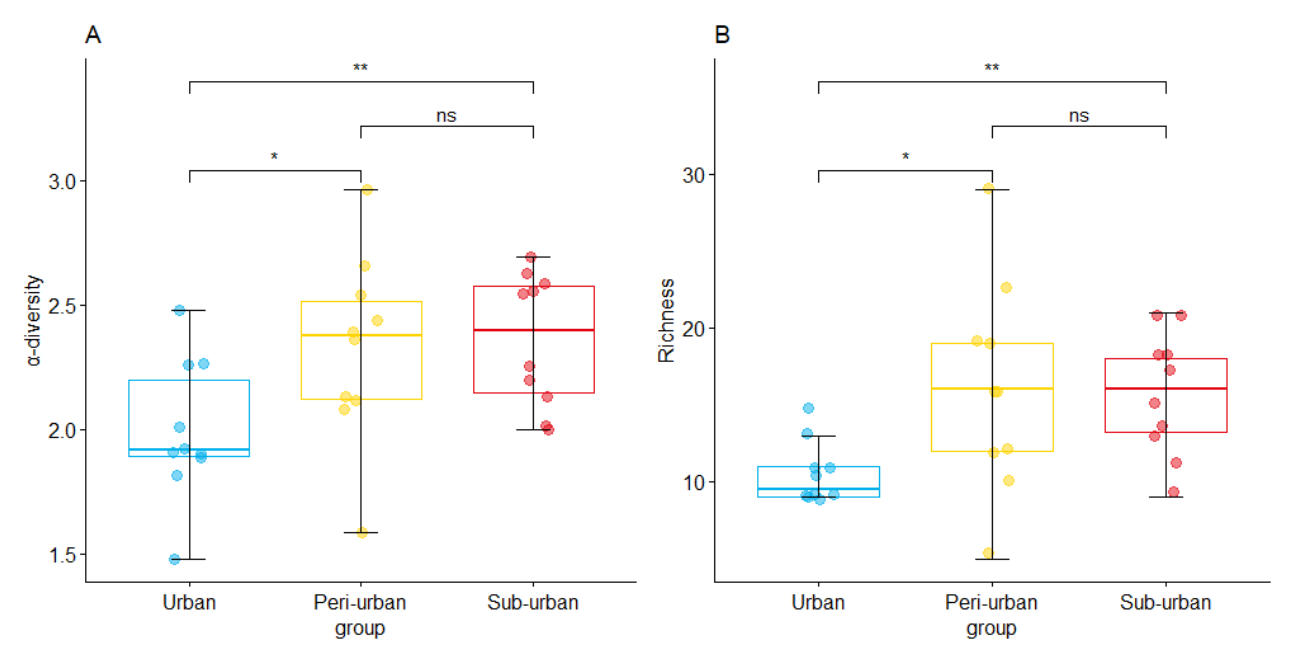
Figure 3. Bird overall α -diversity ( A ) and richness ( B ) under different urbanization types of mountain parks. Boxplots show the range of data about the median, with open circles representing outliers and filled circles representing the mean. Stars indicate significance levels (ns = not significant; * = p < 0.05; ** = p < 0.01).